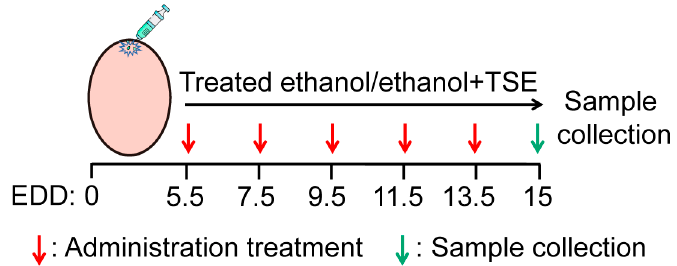
Figure 1. Schematic diagram of chicken embryo treatment